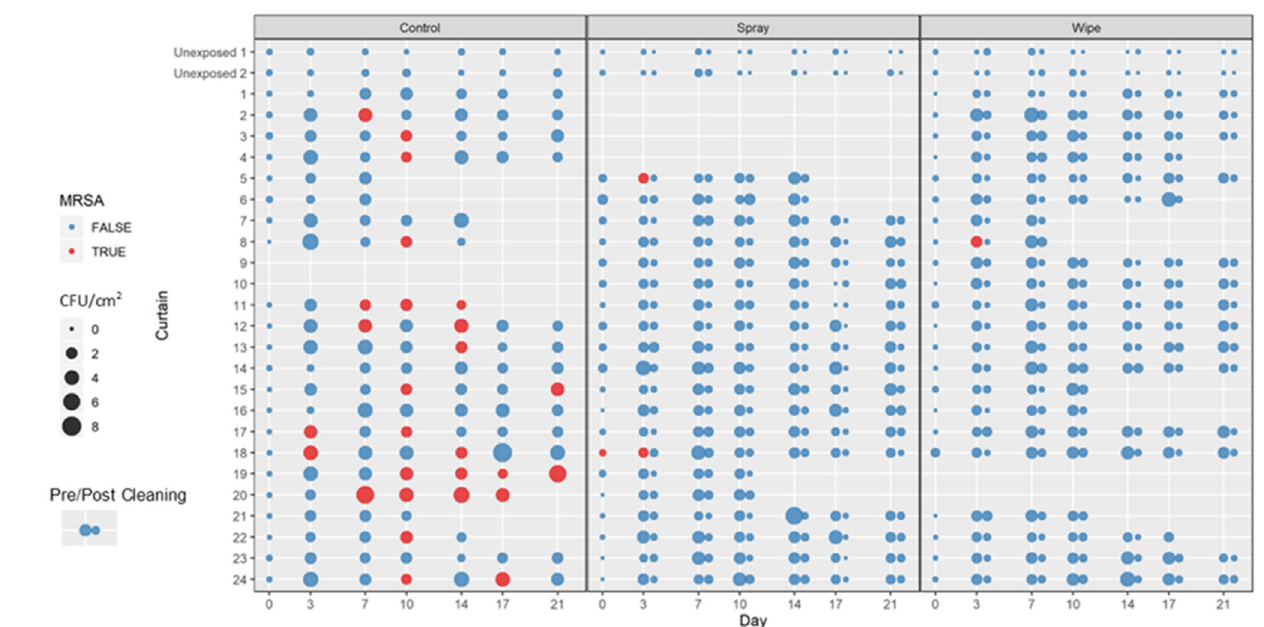
Figure 3. Pre/Post cleaning CFU/cm 2 and presence of Methicillin-resistant Staphylococcus aureus (MRSA). Data shown as CFU/cm 2 at each time point. The size of the circles indicates the degree of contamination with a larger circle being more contaminated. MRSA colonization on the curtain is shown with a red